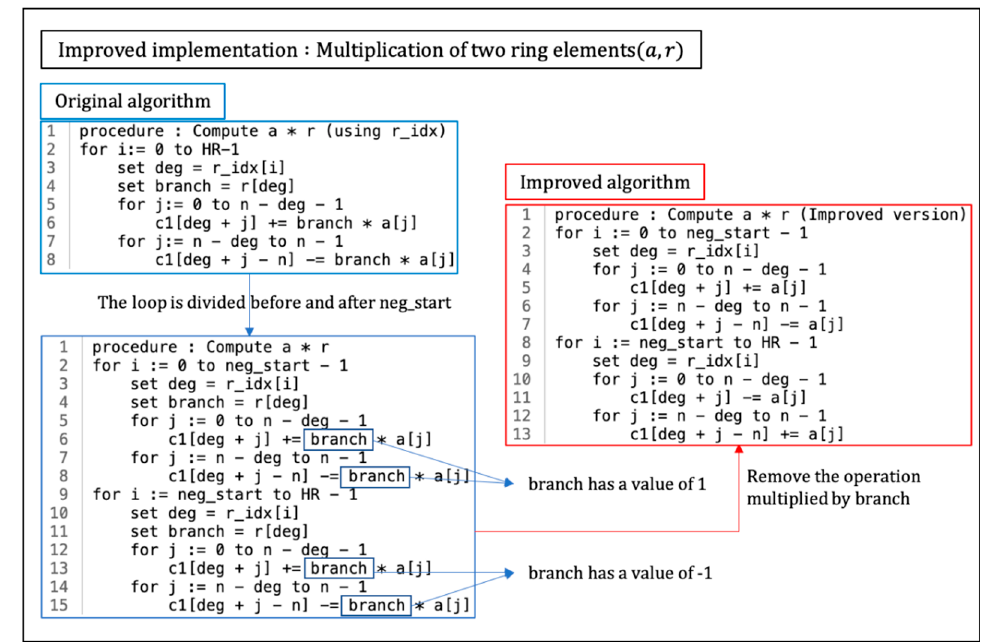
Figure 2. Details of the first method (the proposed implementation is indicated in red.).